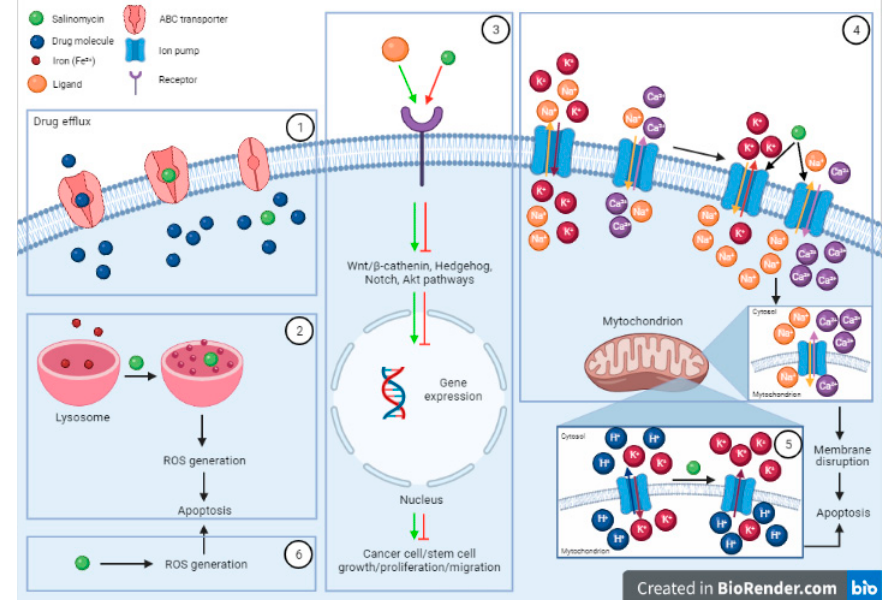
Figure 2. The mechanism of action of salinomycin: ( 1 ) Interfering with ABC transporters; ( 2 ) Accumulation and seques- tration of iron in lysosomes; ( 3 ) Interfering with the Wnt/ β -catenin, Hedgehog, Notch, and Akt signaling pathways; ( 4 ) and ( 5 ) Interfering with ion pumps; ( 6 ) Induction of reactive oxygen species (ROS) (Figure created with BioRender.com [accessed on 25 June 2021]).